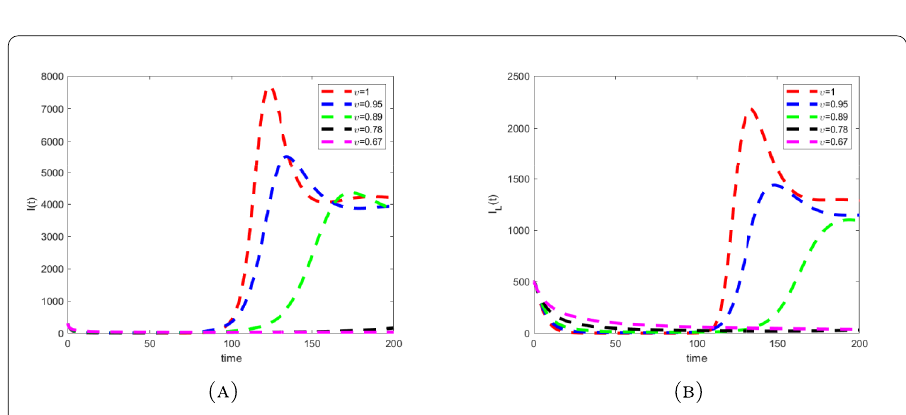
Figure 3 Dynamical outlook of the infective class that aren’t under lockdown and infective class that are under lockdown with different fractional-order values